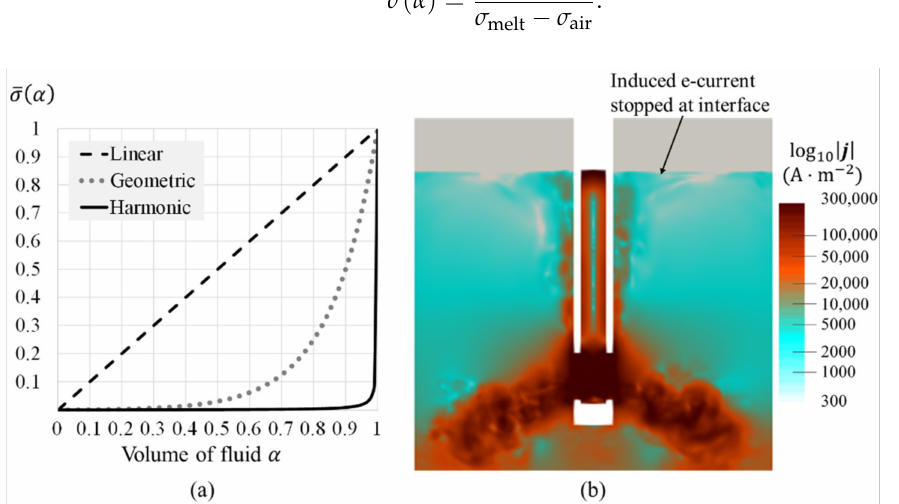
Figure 2. Electrical conductivity at the interface: ( a ) comparison of the linear, geometric, and harmonic interpolations; ( b ) induced e-current density (harmonic interpolation of the e-conductivity).